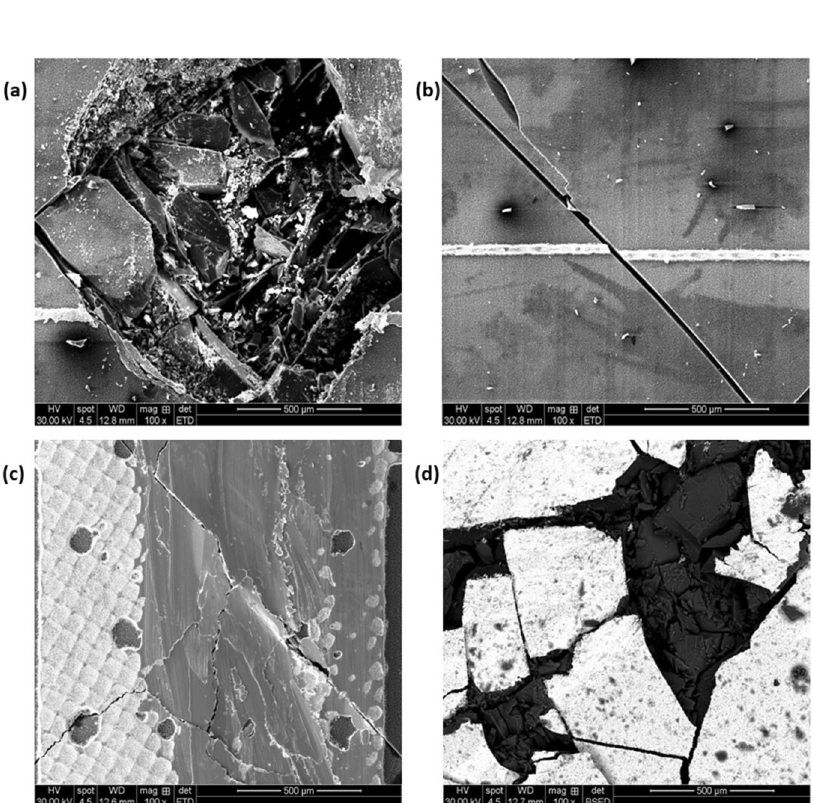
Fig. 9 SEM images of four different solar cell samples. a Breakdown in the surface. b Discontinuity in the cell fi nger. c Discontinuity in the cell busbar. d Breakdown in the back sheet of the solar